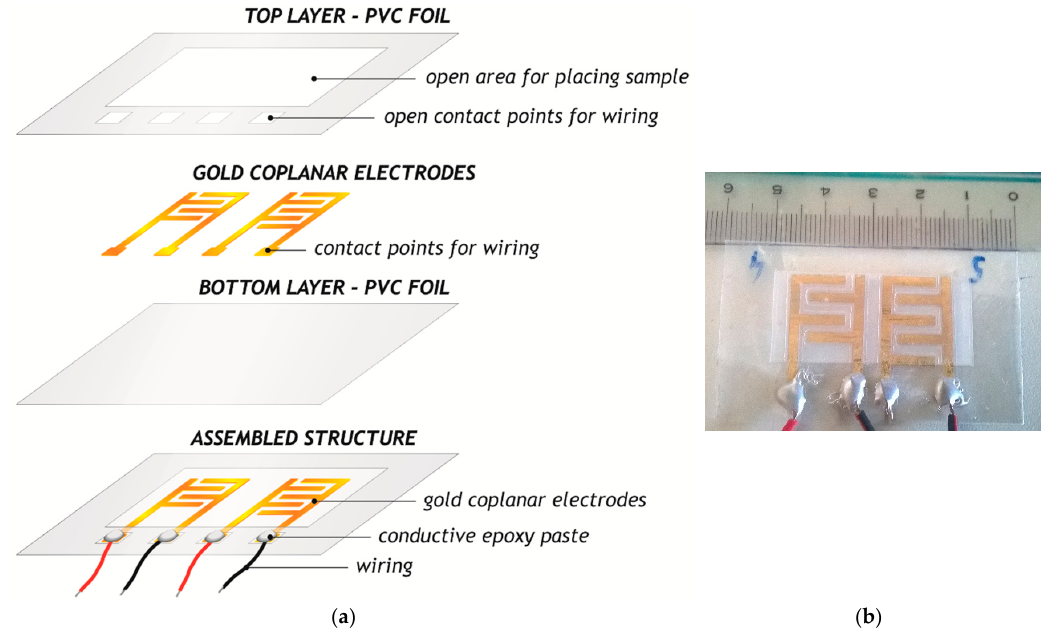
Figure 2. ( a ) Design of separate layers, and ( b ) the fabricated interdigitated capacitor (IDC)-based